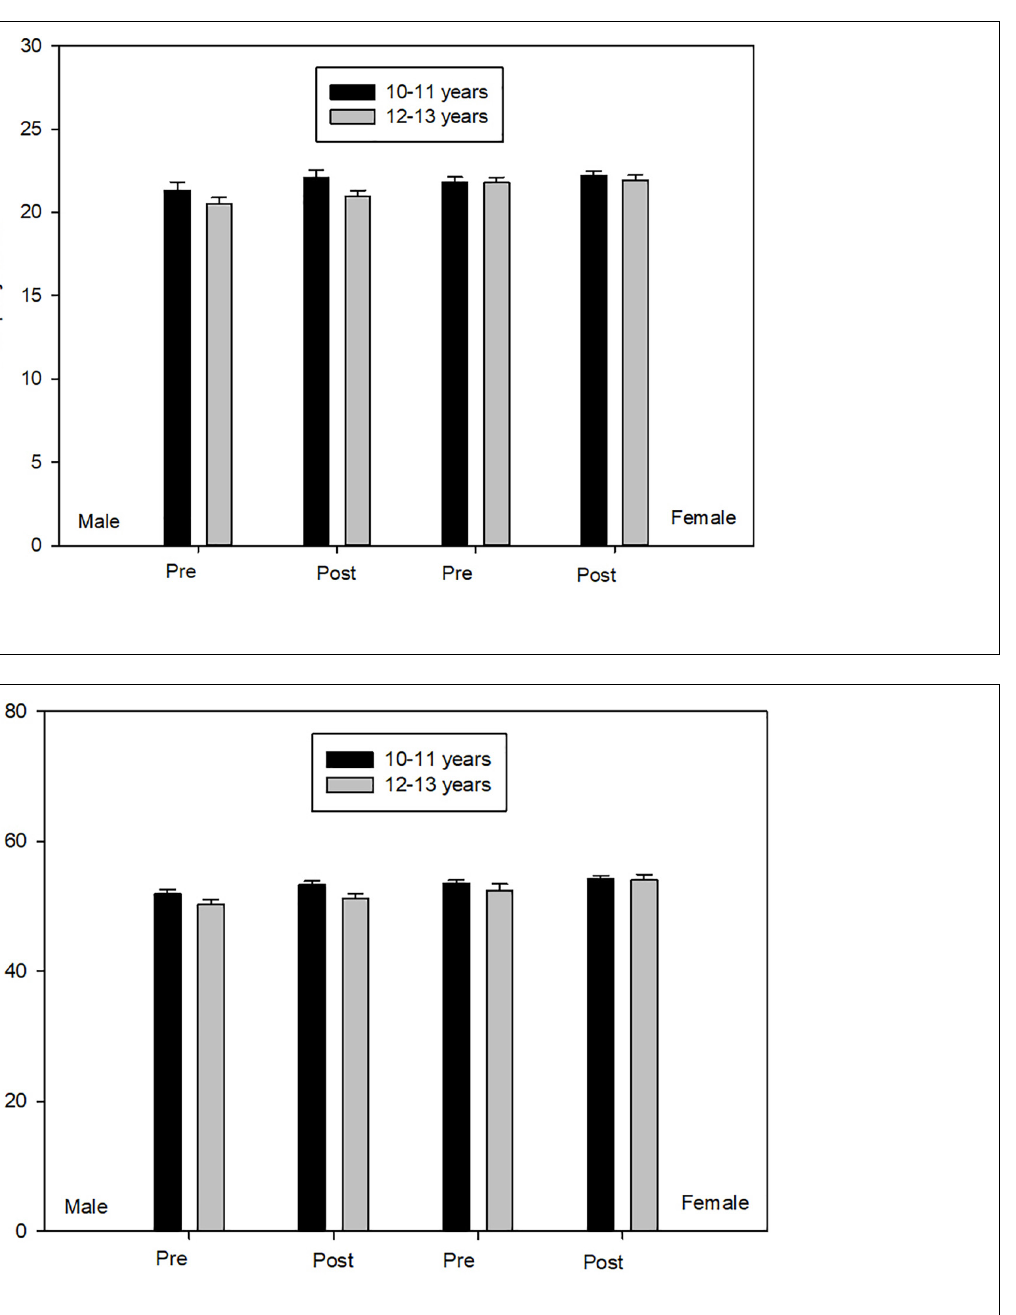
FIGURE 5 | Social